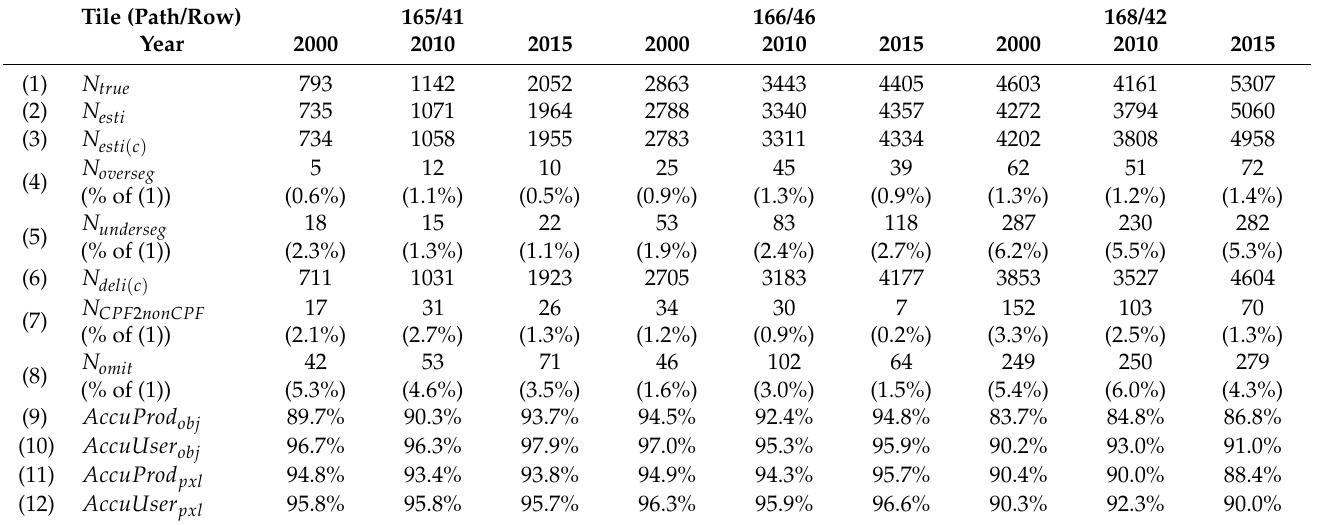
Table 3. The accuracy of center-pivot field (CPF) delineations evaluated against ground truth data for three Landsat tiles (paths/rows 165/41, 166/46, and 168/42) for 2000, 2010, and 2015. N true and N esti indicated the number of CPFs on the ground truth map and framework-delineated map. A CPF was correctly detected (row 3; N esti ( c ) ) if it was classified as a CPF by the CNN and both S over and S under values <= 40%. For a correctly detected field, it was classified as being incorrectly delineated due to high over- or under-segmentation values ( S over or S under > 40%), with N overseg and N underseg indicating the number of over-segmented and under-segmented CPFs. The number of correctly delineated CPFs (row 6; N deli ( c ) ) was calculated as Equation (2). N CPF 2 nonCPF indicated the number of CPFs being detected as non-CPFs (i.e., fields showing rectangle shapes). The undetected CPFs (row 8; N omit ) were defined as a union of CPFs (1) being identified as noise by CNN, and thus excluded by the framework, (2) not intersected with any framework-delineated fields, or (3) with both the S over and S under values > 40%, under which circumstances the framework-delineated field and ground-truth field were treated as two different fields. N omit was calculated as Equation (7). AccuProd obj and AccuUser obj indicated the producer’s and user’s accuracy at the object level, and AccuProd pxl and AccuUser pxl indicated the producer’s and user’s accuracy at the pixel level, which were calculated using Equations